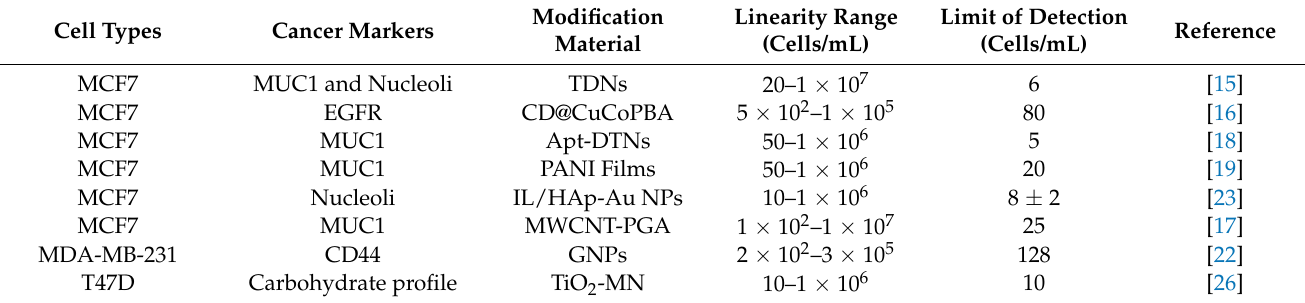
Table 1. Electrochemical cytosensors for breast cancer cell